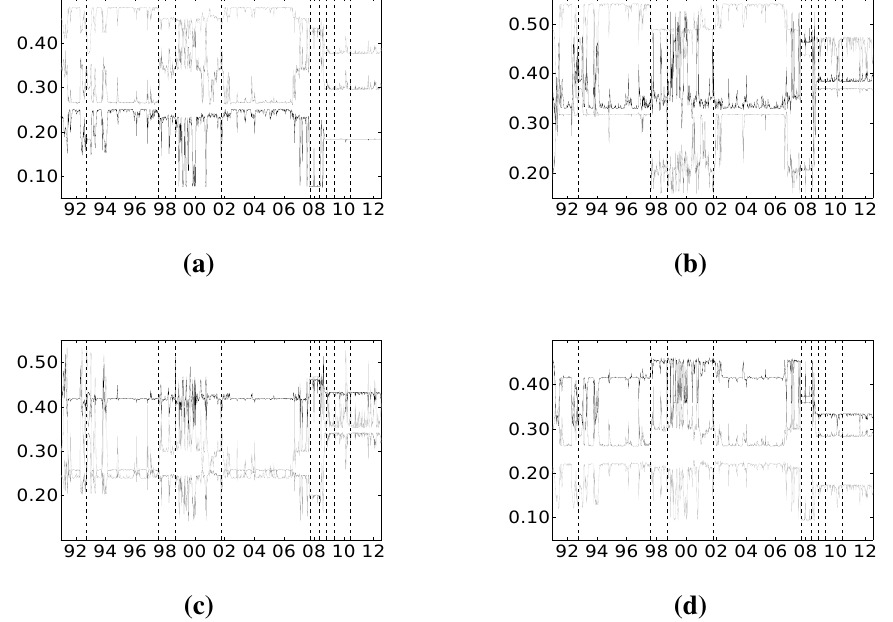
Figure 4. Shalpey value ∆ M -CoVaR of the different sectors against banks ( a ), financial services ( b ), life insurance ( c ) and non-life insurance ( d ). Vertical dotted lines represent major financial downturns: see Figure 1 for a detailed description. (a) Financial services (light gray), life (gray) and non-life (dark) insurance against banks; (b) banks (light gray), life (gray) and non-life (dark) insurance against financial services; (c) banks (light gray), financial services (gray) and non-life insurance (dark) against the life insurance index; (d) banks (light gray), financial services (gray) and life insurance (dark) against the non-life insurance